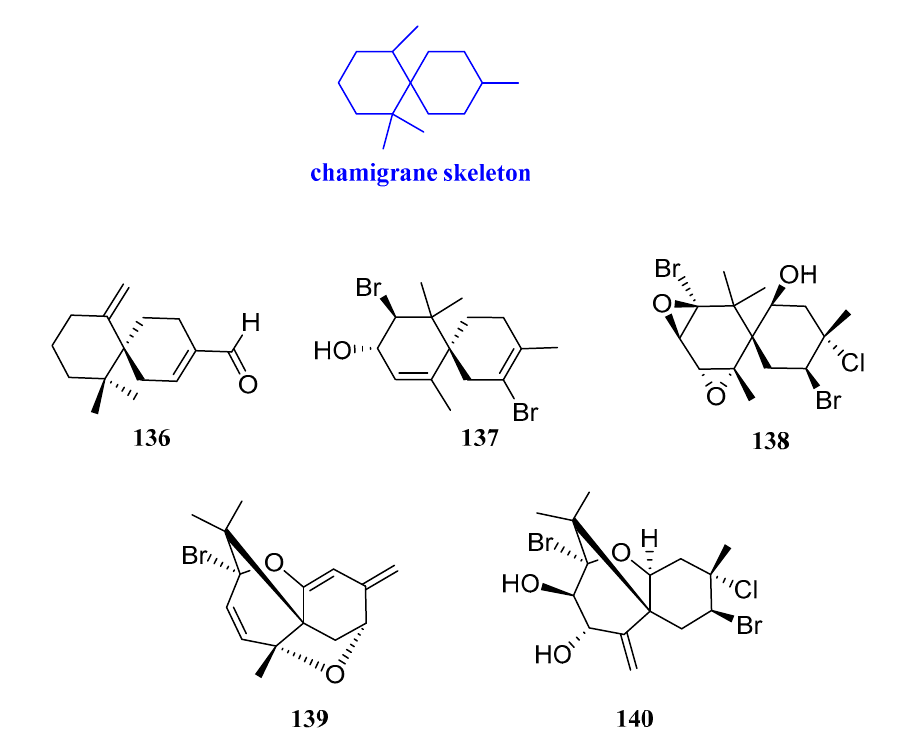
Figure 12. Structures of chamigrane-type sesquiterpenoid 136 – 140 .